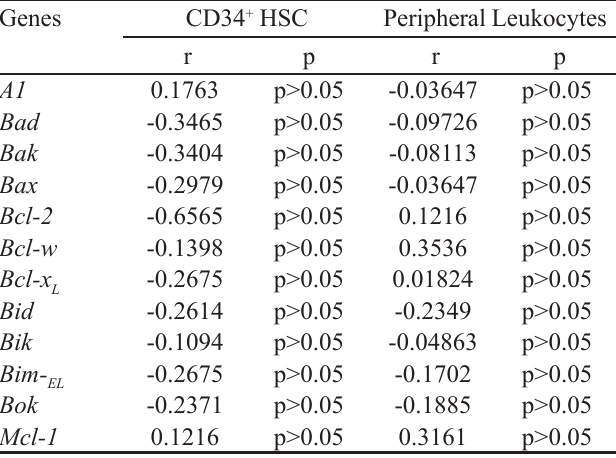
and L proteic EL